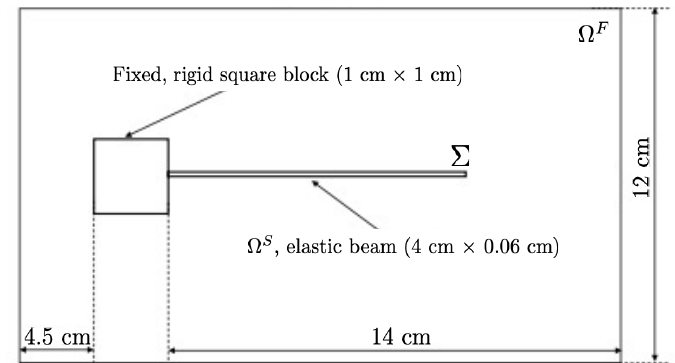
Figure 7. Test case 2: Geometrical configuration and